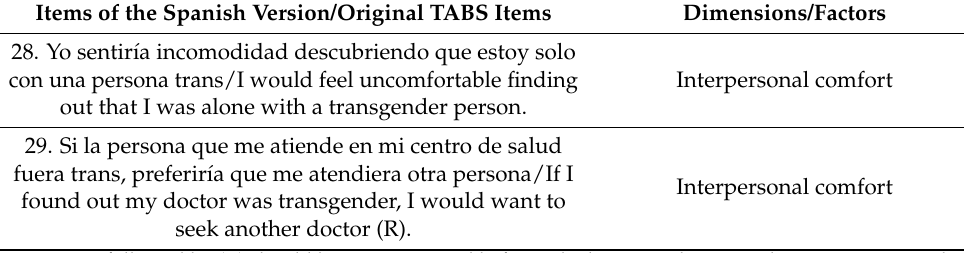
Table A1. Cont. Items of the Spanish Version/Original TABS